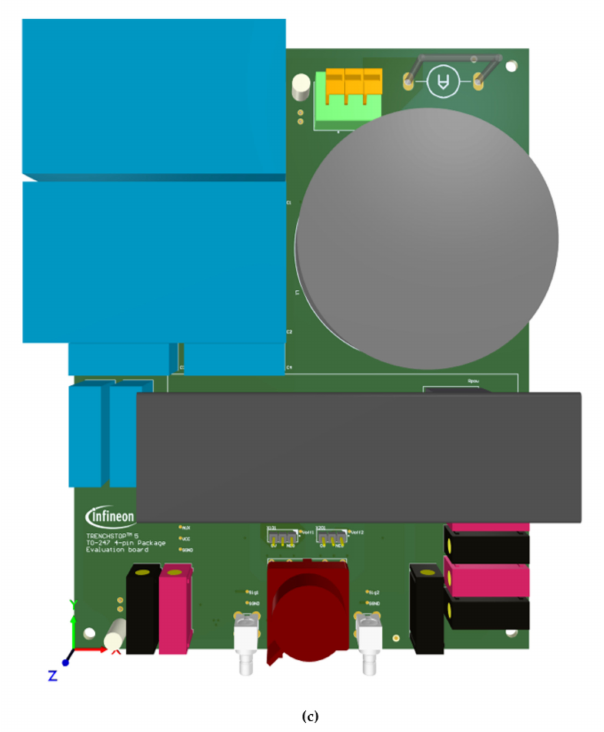
Figure 5. ( a ). Printed circuit board (PCB) Layout. ( b ). Imported board showing the position of components, holes, and mount points. ( c ). Three-dimensional representations of the top and bottom of the board in the PCB design software.